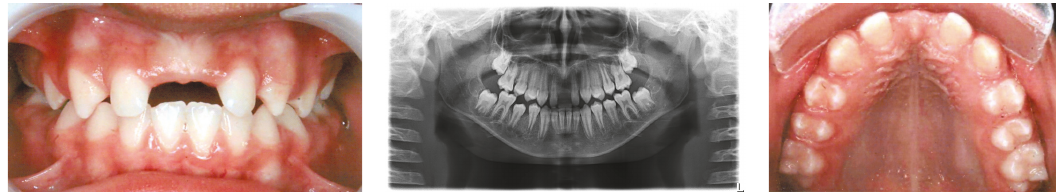
Figure 1: Clinical and radiographic aspects of the edentulous region with transverse deficiency due to mesialization of the lateral incisors.